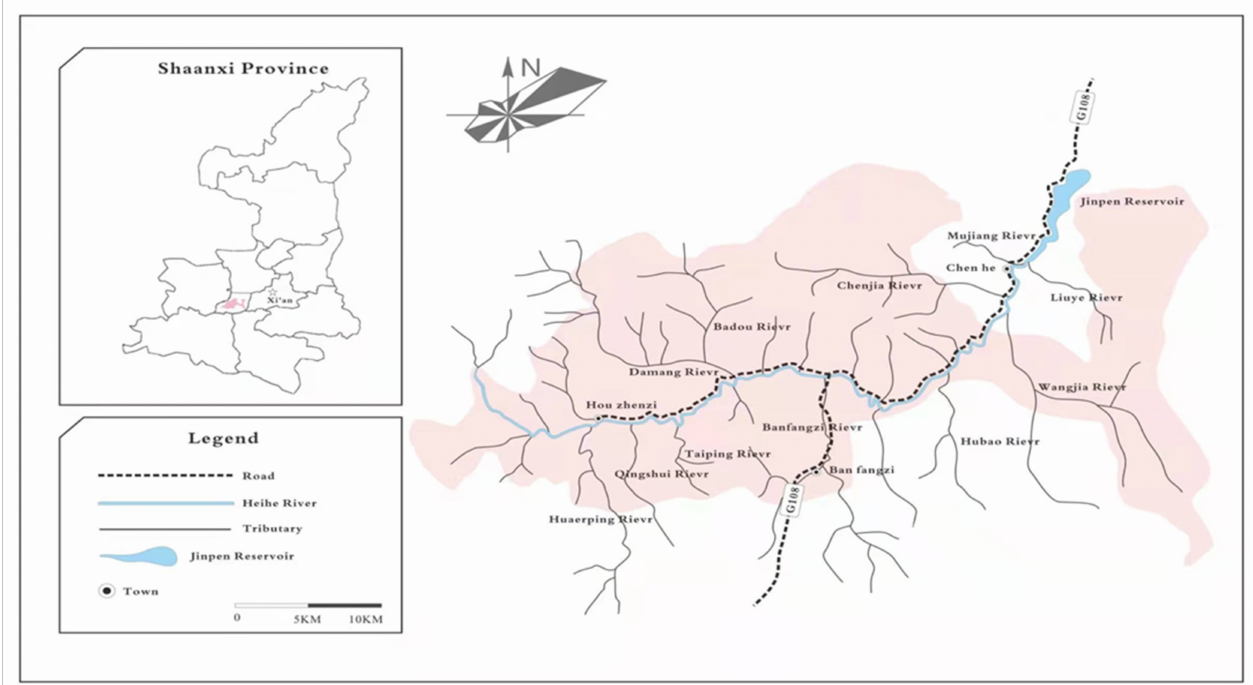
Figure 1. Study area